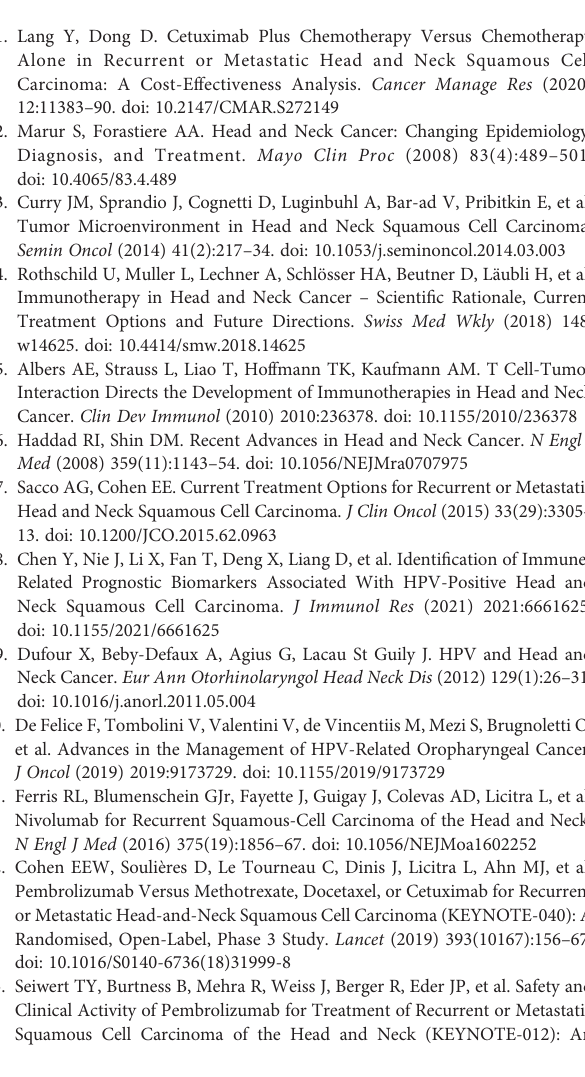
Supplementary Table 1 | PRISMA checklist: characteristics of selected studies for fi nal